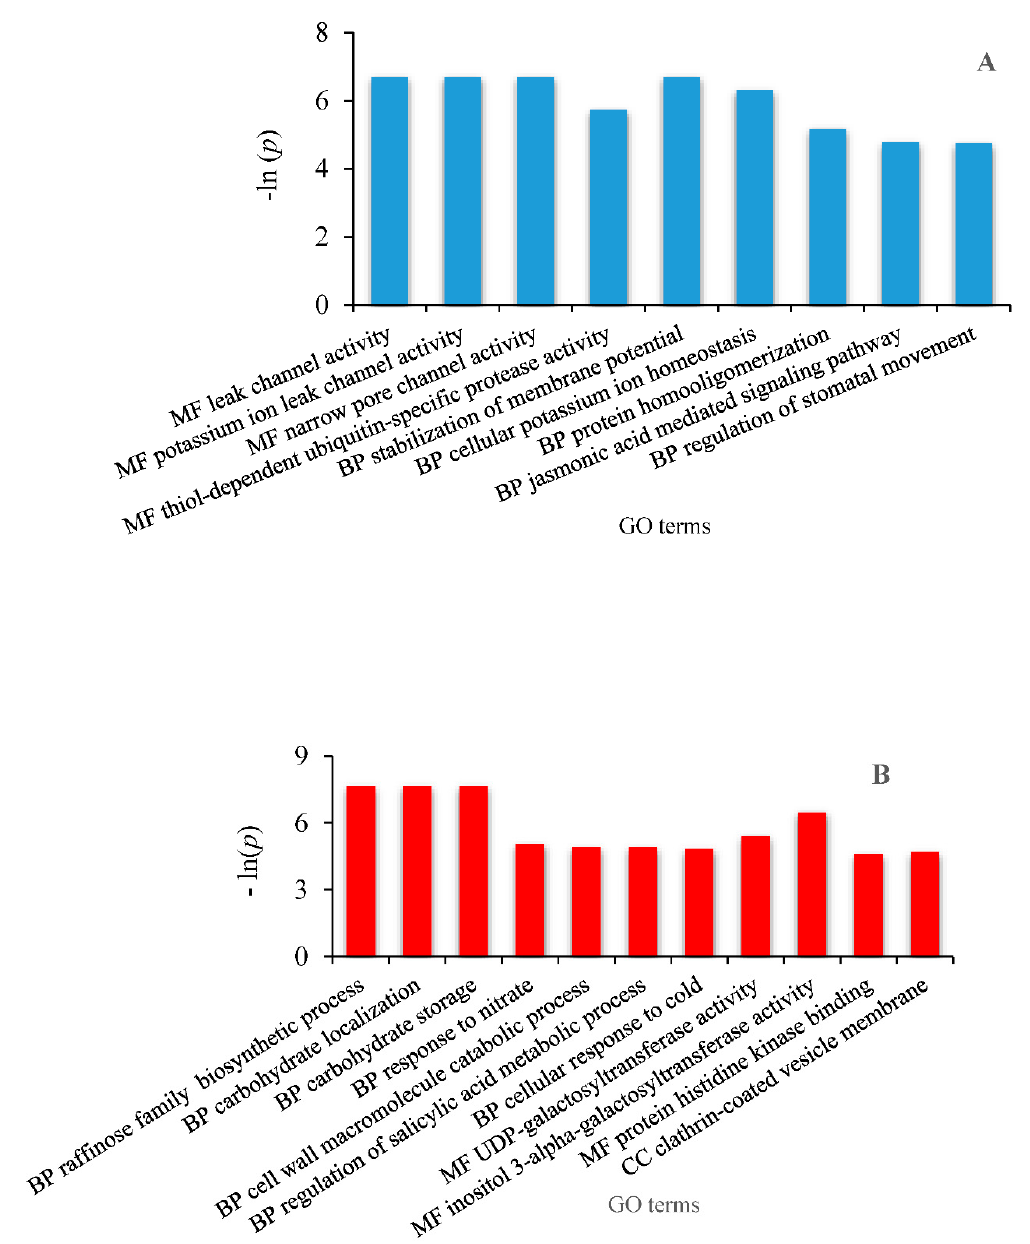
Figure 6. GO annotation of differential transcripts of Q. pubescens in spring as a function of the enrichment p value p < 0.01. ( A ) Upregulated features and ( B ) downregulated features. MF, molecular function; BP, biological process; CC, cellular component.